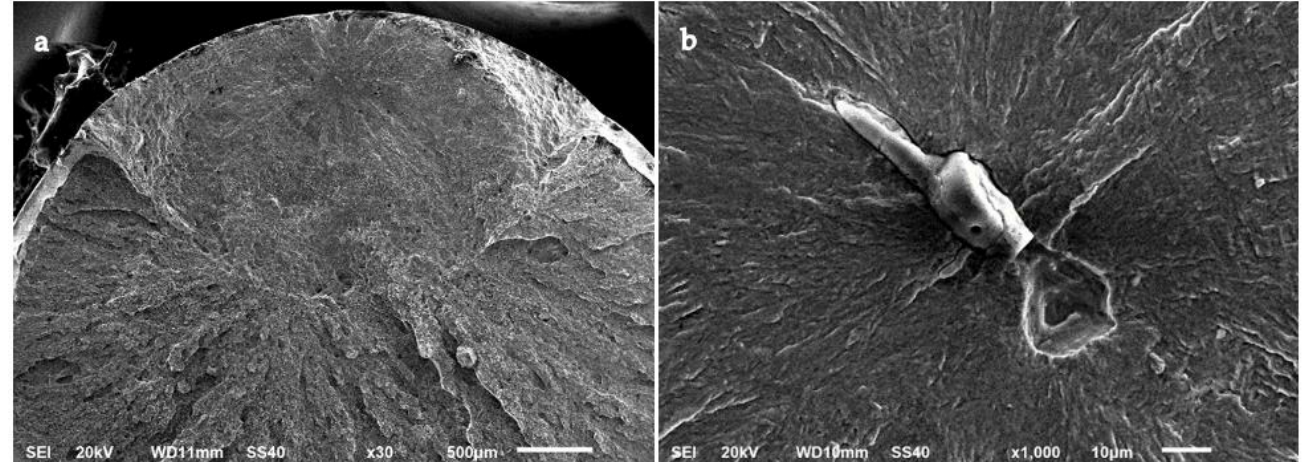
Figure 12. Internal crack initiation and fish-eye region of an A-type steel specimen tested in air to a maximum stress of 1110 MPa (78% YS) for 833,119 cycles at ( a ) ×30 and ( b ) ×1000.